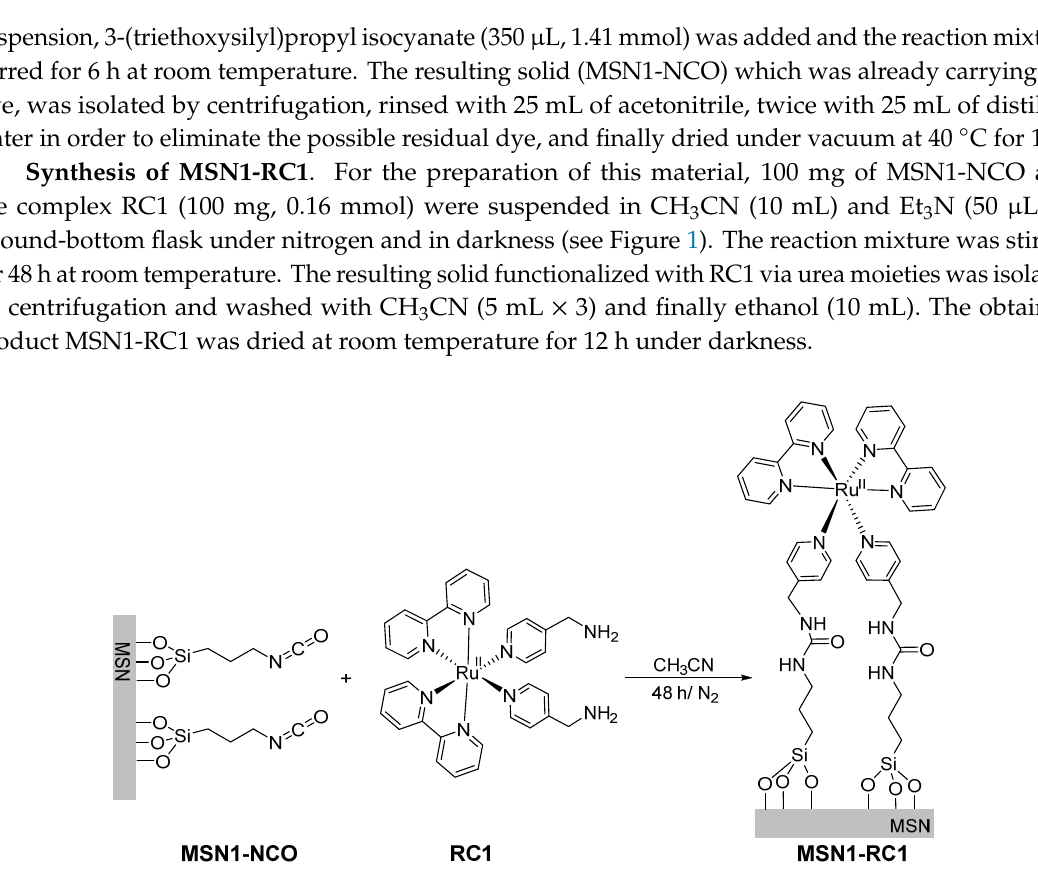
Figure 2. Preparation of MSN2-RC2 by grafting of RC2 onto the mesoporous surface of MSN2-Py.